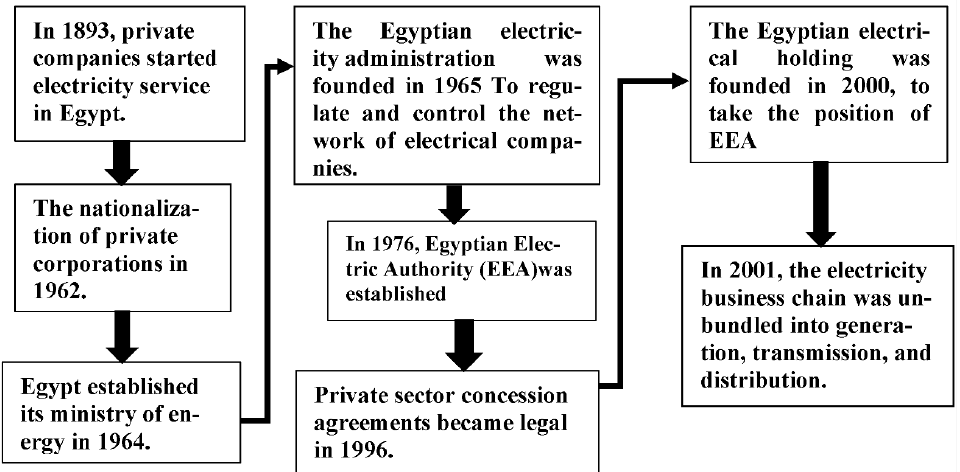
Figure 4. The electric sector history in Egypt overview.